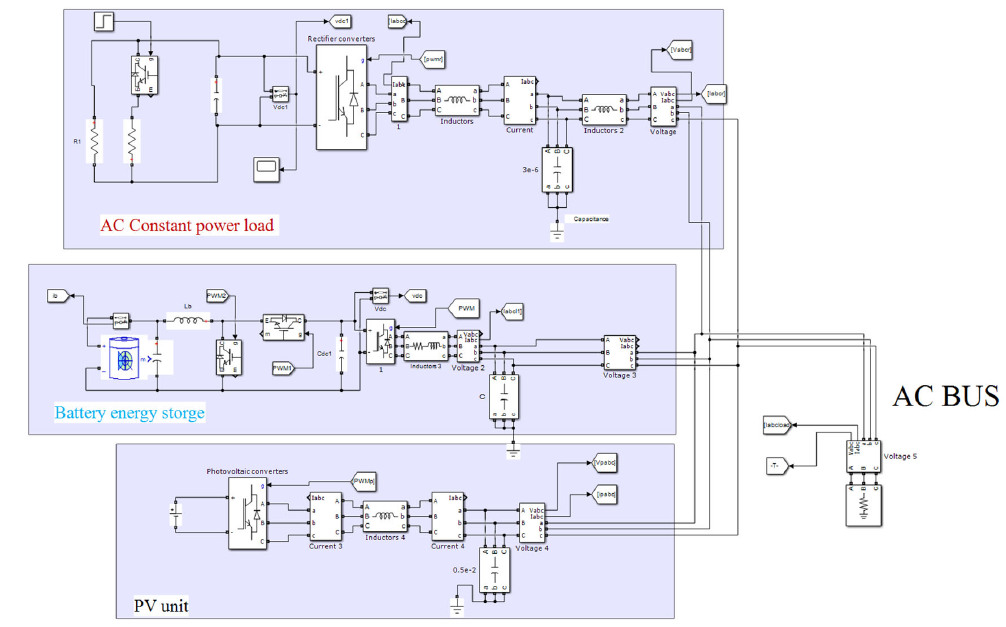
Figure 8. The simulation mode l of AC microgrids.